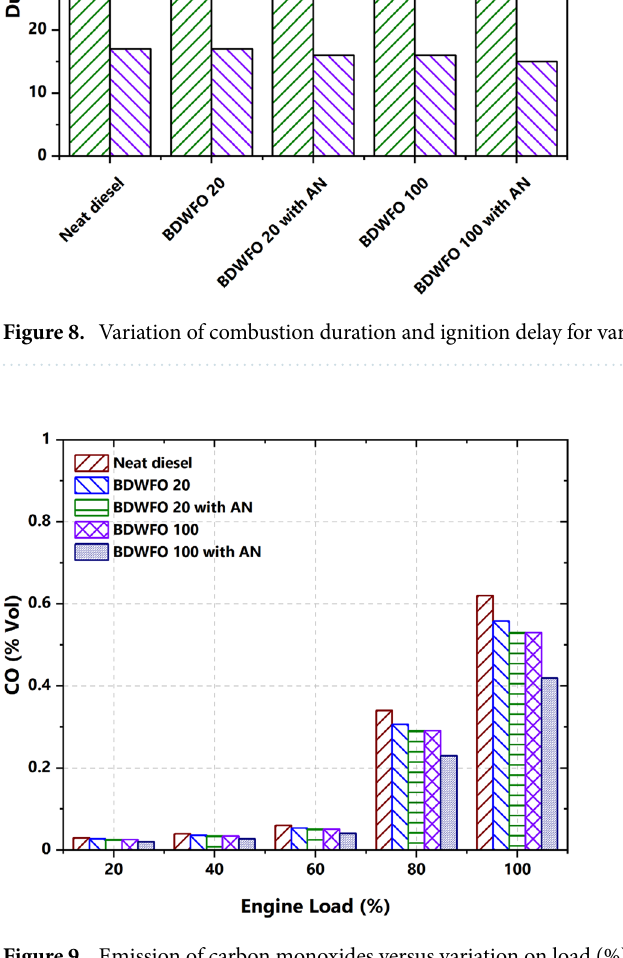
Figure 9. Emission of carbon monoxides versus variation on load